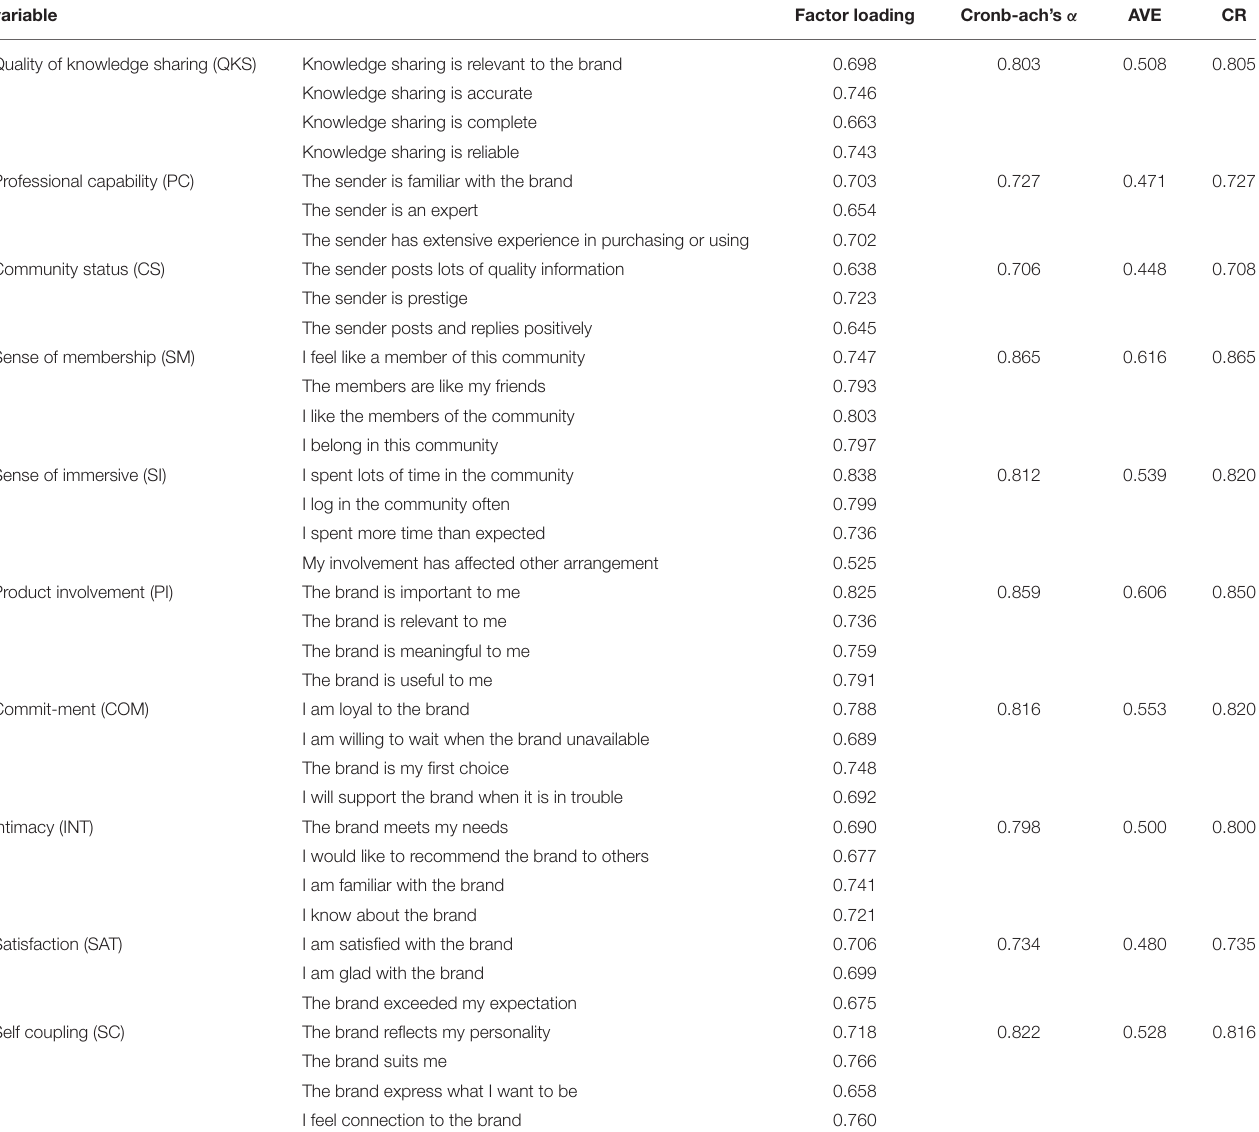
TABLE 2 | Variable reliability testing and confirmatory factor